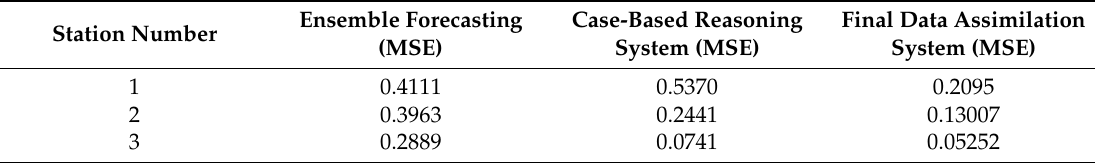
Table 2. Neural network-based data assimilation